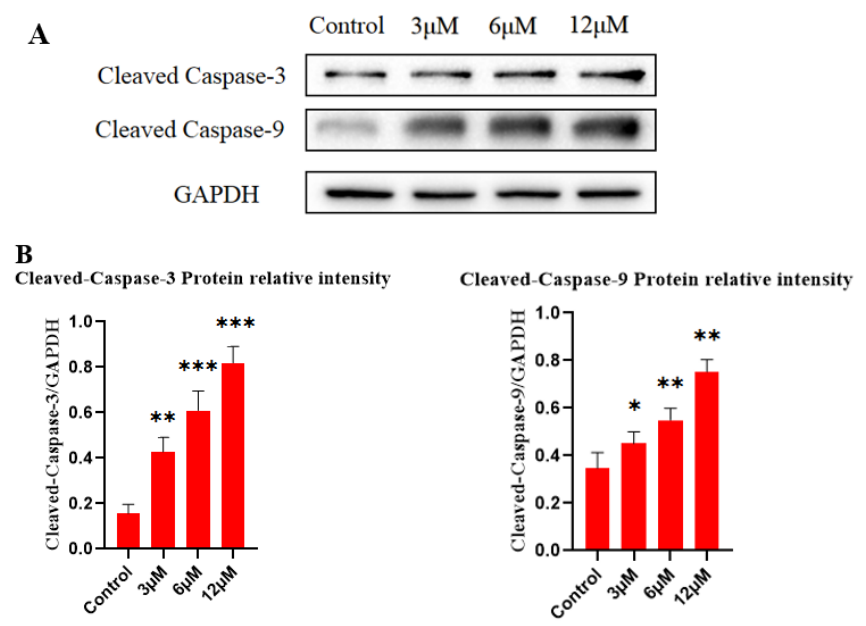
Figure 10. Effects of compound 8f on the expression of cleaved caspase-3 and cleaved caspase-9 in MCF-7 cells. ( A ). Western blot analysis showing cleaved caspase-3 and cleaved caspase-9 protein expression level. ( B ) Data were revealed as the means ± SD for independent tests in triplicate. * p < 0.05, ** p < 0.01, *** p < 0.001 vs. control ( 8f 0 μ M) group.